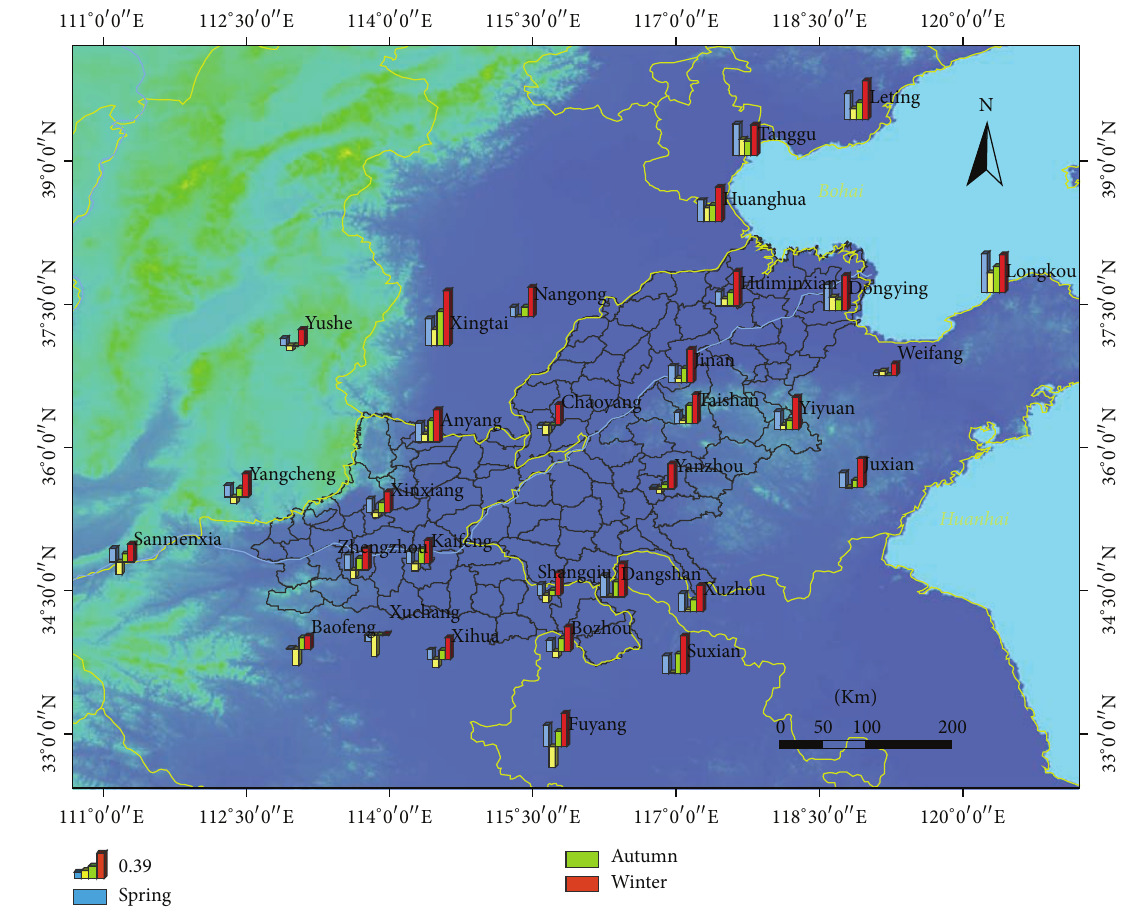
Figure 6: Average temperature change trend rates at each station in the Lower Yellow River Region (unit of measurement ∘ C/10